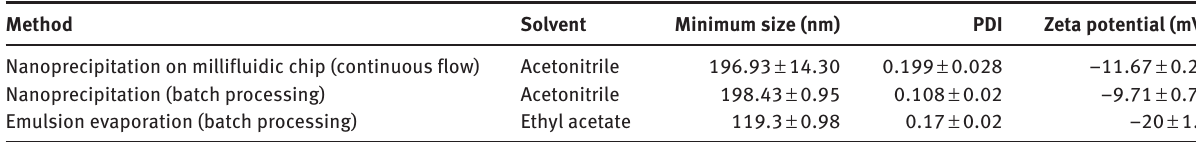
Table 1: Comparison of size, size distribution, PDI, and zeta potential of nanoparticles prepared using the continuous flow and batch processing